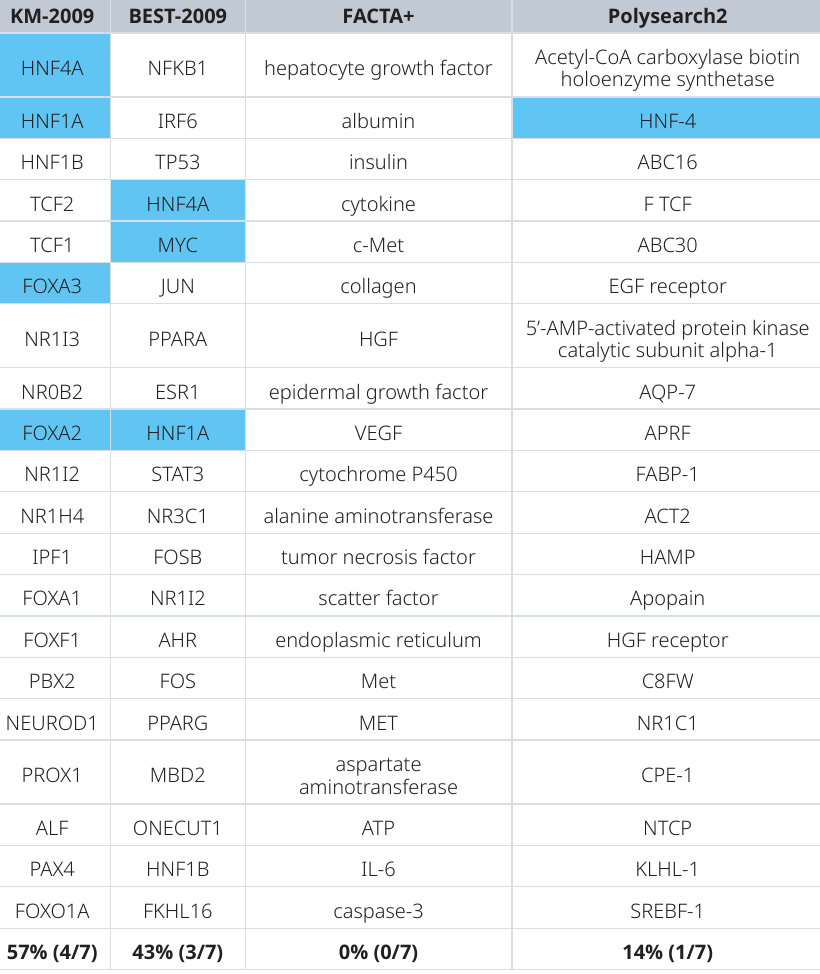
Table 3. Hepatocyte transcription factor search. Landmark factors are highlighted in blue and the bottom row shows Recall@20. Note that KinderMiner and BEST have been censored to articles published through 2009, whereas the other methods have no such censoring, giving them the advantage of access to the landmark papers and